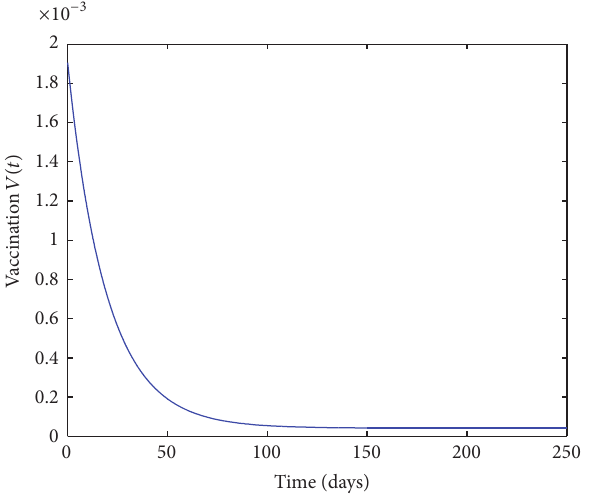
Figure 23: Culling effort 𝜌 𝐷 𝐷(𝑡) when a daily culling rate of 𝜌 𝐷 = + 0.002𝑆(𝑡) and antiviral treatment 0.1 , vaccination law 𝑉 = 0.2𝑏 1 𝐼(𝑡) = 0.01𝐼(𝑡) are applied. 𝜉(𝑡) = 𝐾 𝜉